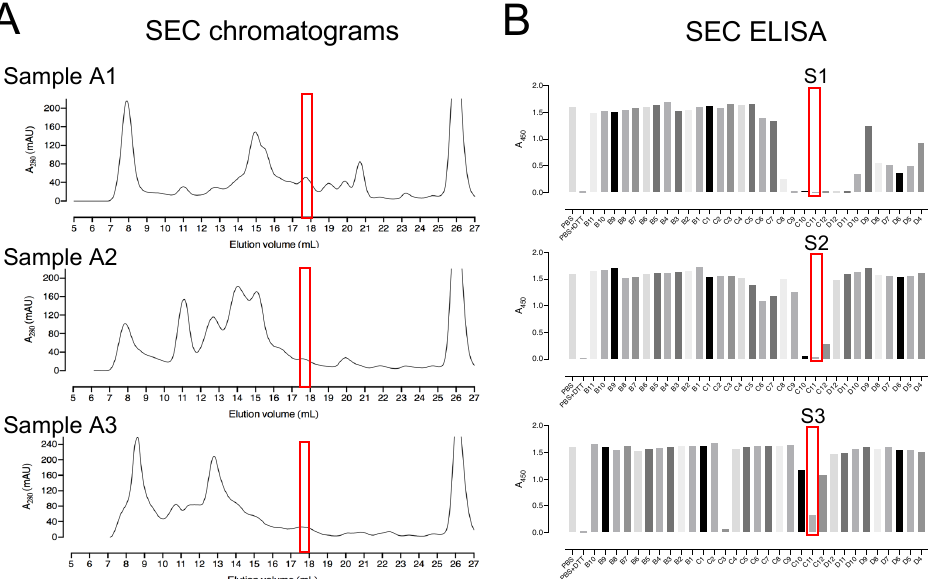
Figure 3. Size-exclusion chromatography as a second step for the purification of enzymes with deCoAlation activity. ( A ) Size-exclusion chromatograms of A1, A2, and A3 anion exchange fraction pools. The black line represents the A 280nm , and the peak eluted at 25–28 mL elution volume represents DTT. ( B ) The red box indicates the fractions showing the highest deCoAlation activity (S1, S2, and S3) measured by ELISA. The bar graph was generated by using GraphPad Prism 8 (version